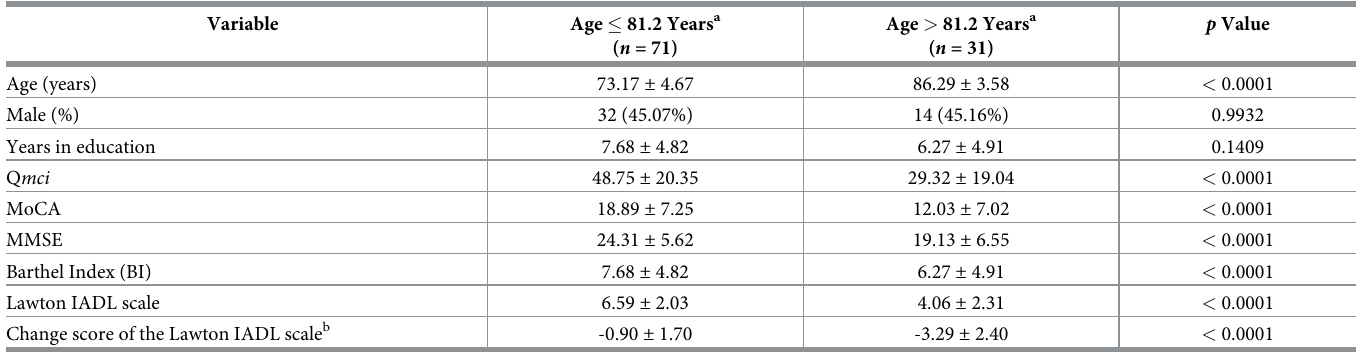
Table 1. Univariate analysis of the demographic and clinical characteristics between the subjects of two age groups.